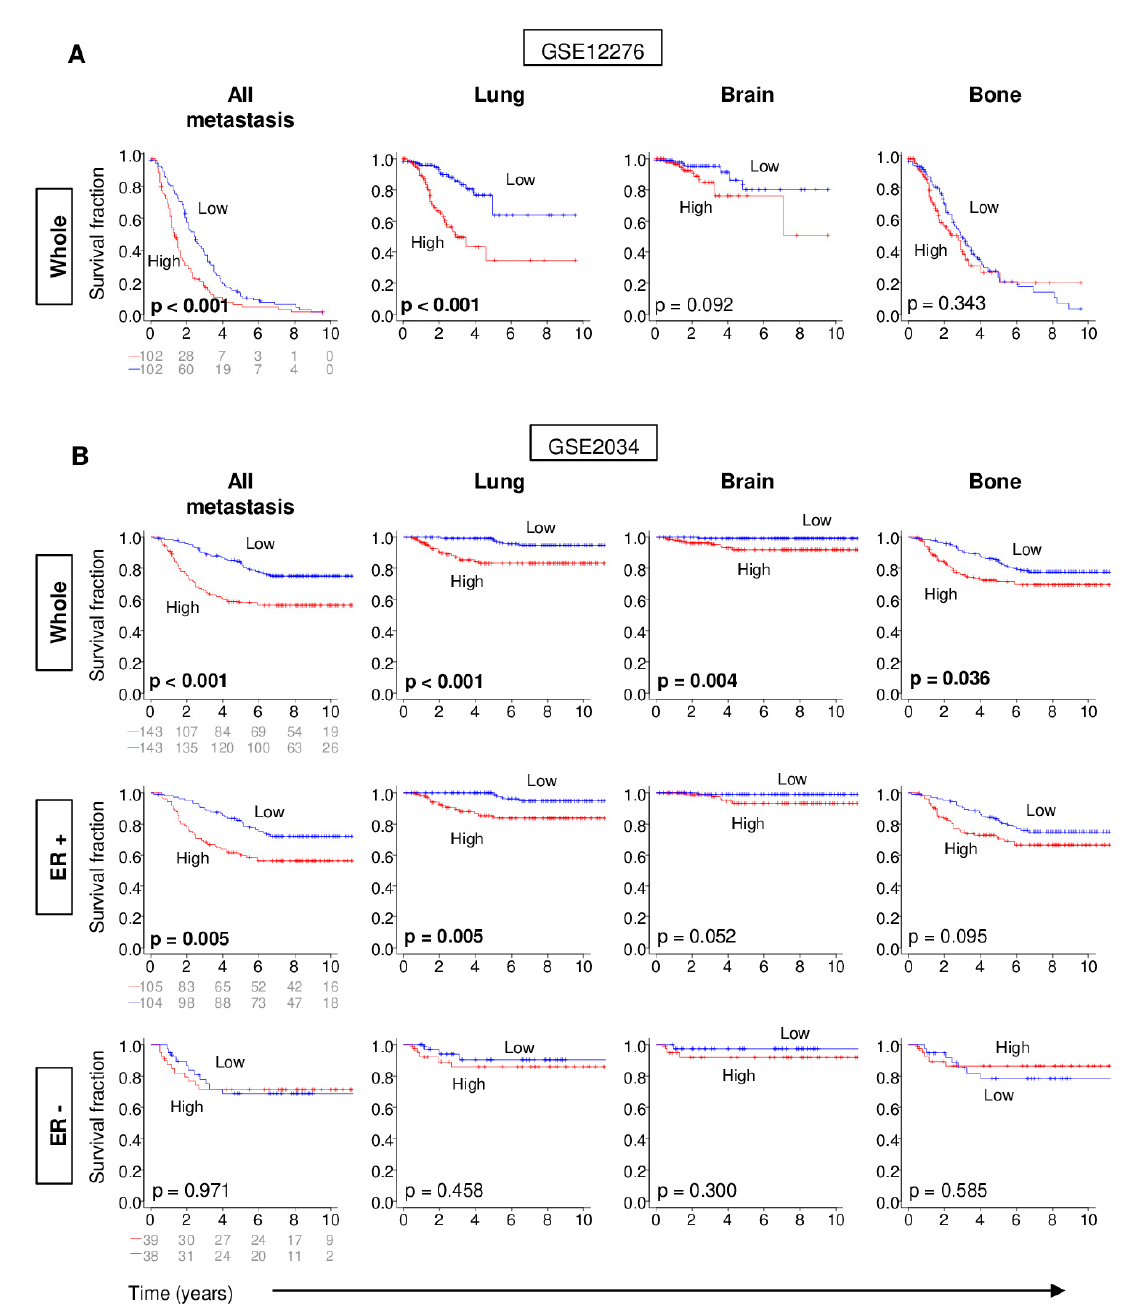
Figure 3. ( A ) The Kaplan–Meier survival plots depicting metastasis-free survival for metastasis to lung, brain, or bone based on G2M pathway score of the primary tumors in the GSE12276 and ( B ) in the GSE2034 cohort. In the GSE2034, metastasis-free survival was demonstrated in the whole cohort, ER + , and TNBC subtypes. The median value of the G2M pathway score was used to divide patients into low and high groups. ER, estrogen receptor; TNBC, triple negative breast cancer.